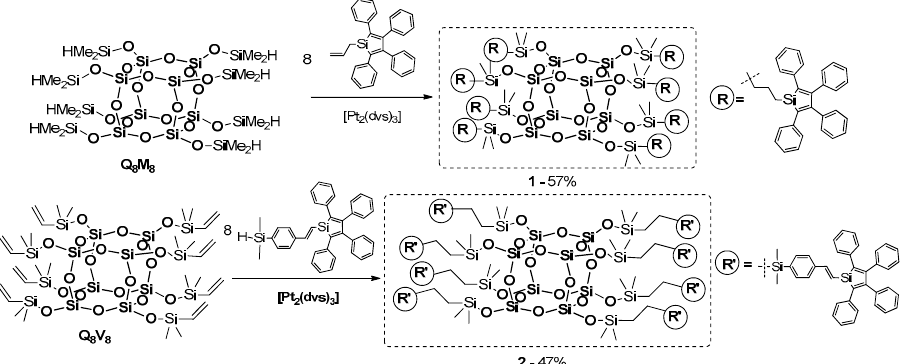
Figure 31. Hydrosilylation-based functionalization of Q 8 M 8 and Q 8 V 8 with allyl-tetraphenylsilole and hydrosilylphenyl-tetraphenylsilole.